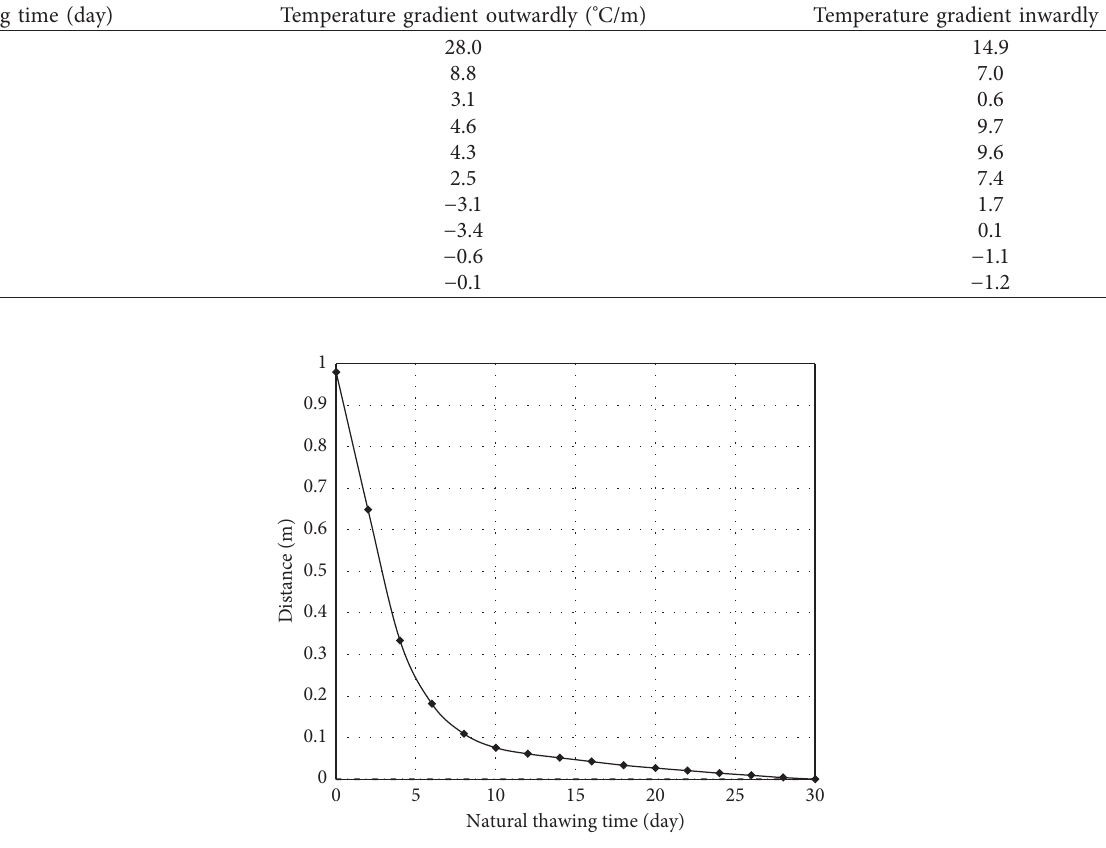
Table 4: Temperature gradient inwardly and outwardly from freeze pipe with different thawing times.